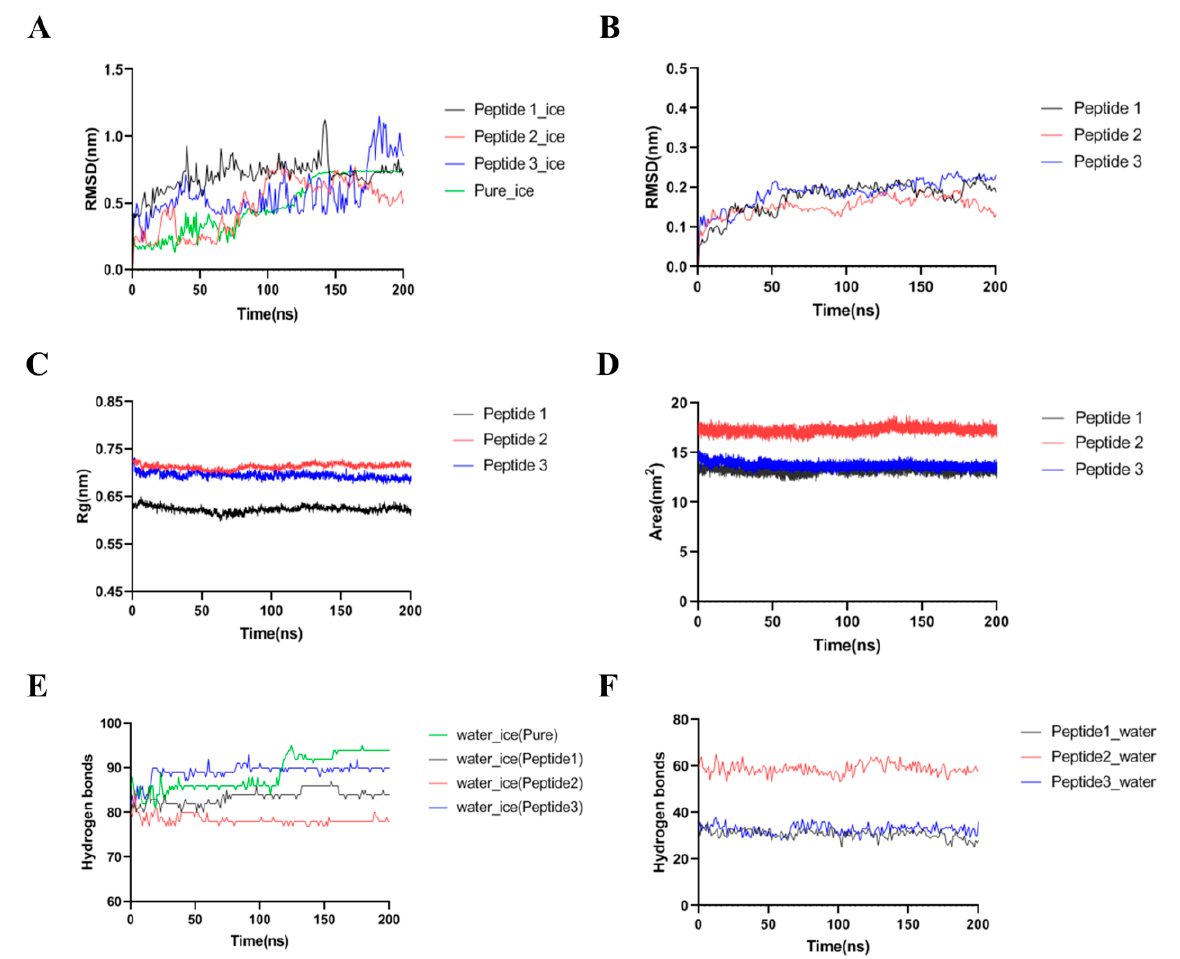
Figure 8. The root mean square deviation (RMSD) of four simulation systems ( A ) and three peptides ( B ). The radius of gyration ( C ) and solvent accessible surface area ( D ) of three peptides during simulation. The numbers of hydrogen bonds formed between water and ice ( E ) and peptides and water ( F ) as a function of time for different systems. Data were expressed as the mean ± SD.